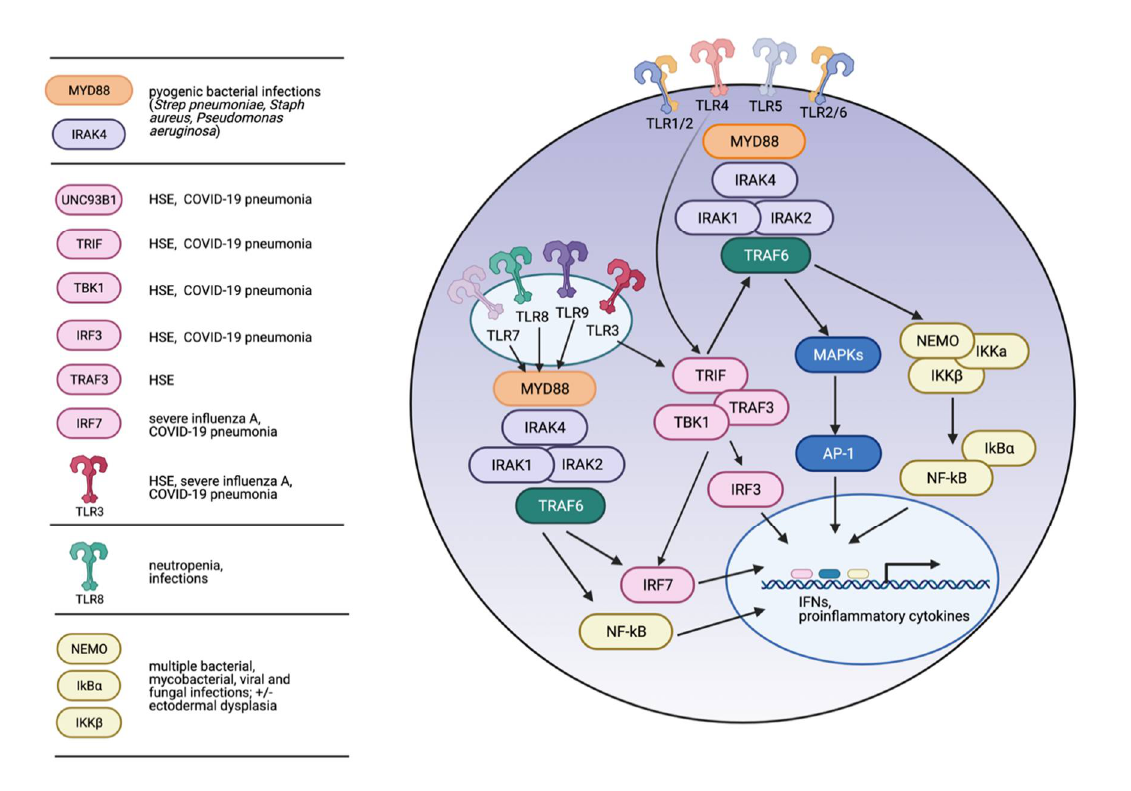
Figure 1. TLR pathway variants and immune deficiencies. TLRs signal via MyD88-dependent or TRIF-dependent pathways. Activated MyD88 recruits IRAKs1/2/4, then TRAF6, and ultimately activates MAPKs and NF- κ B resulting in the production of proinflammatory cytokines. Activated TRIF (via ligation of TLR3 or TLR4) binds to TRAF3 and TBK1, ultimately activating IRF3 and IRF7 to stimulate the production of interferons. TRIF also interacts with TRAF6 to stimulate MyD88-independent activation of MAPKs and NF- κ B. Highlighted on the left are TLR signaling pathway players in which variants have been associated with specific inborn errors of immunity, as indicated. Created with BioRender.com accessed on 27 April